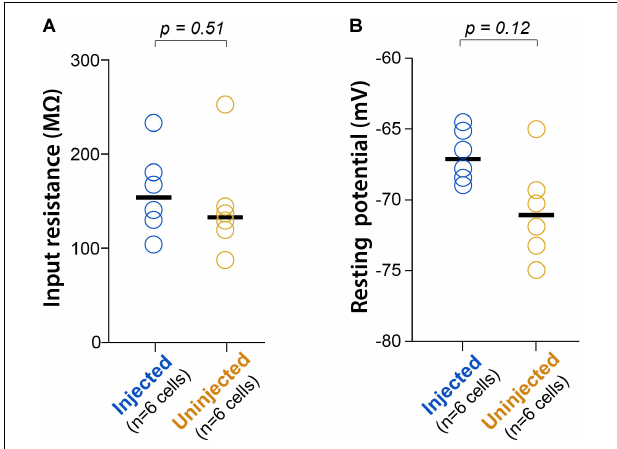
FIGURE 4 | L2/3 neurons expressing GCaMP6s since P1 show normal electrophysiology. (A) Input resistance ( R m ) during whole-cell recordings of L2/3 neurons from P16-17 mice injected with AAV-GCaMP6s at P1, or from uninjected littermates ( n = 2 mice each). Each circle represents data for one cell, bars represent group medians, and p -values are from unpaired rank-based two-group comparison with 10,000 resamples. (B) Resting membrane potential ( V m ) for the same comparison.